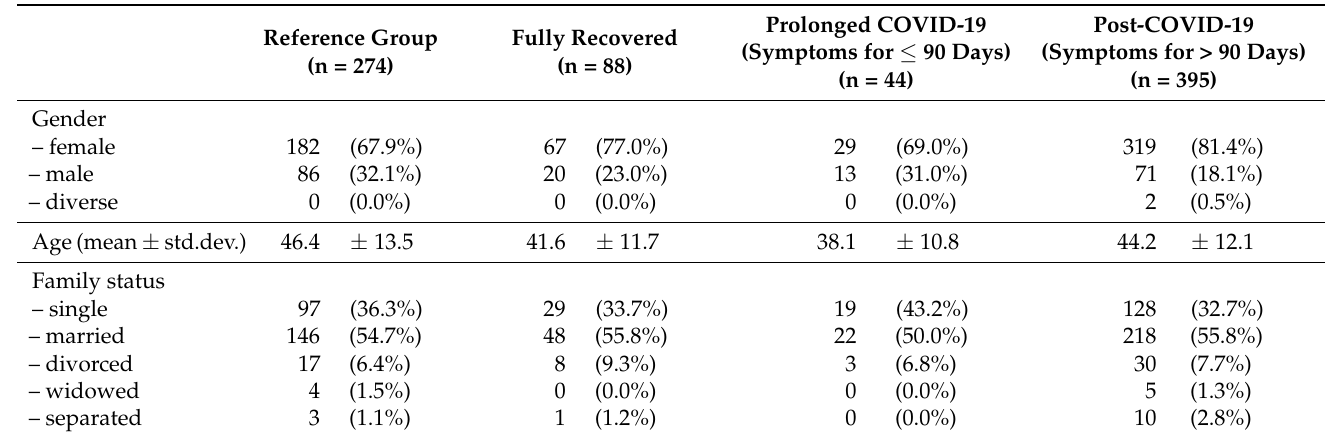
Table 1. Demographic data.